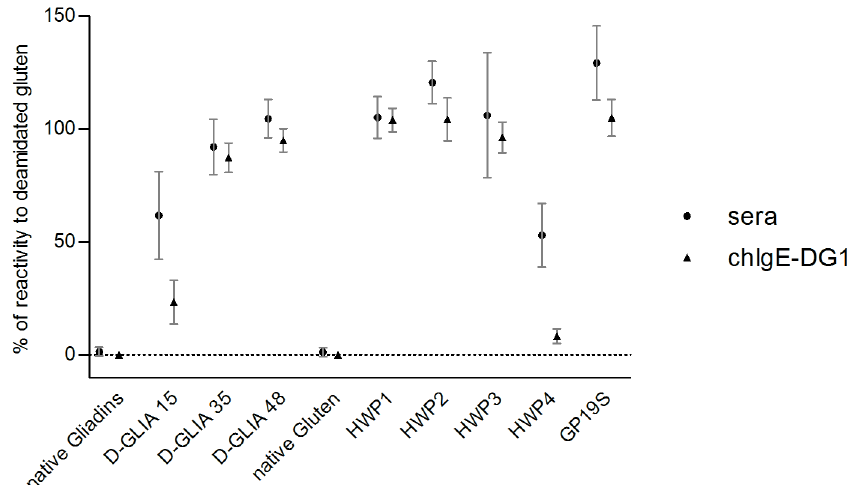
Fig 6. Reactivity of chimeric IgE-DG1 to various deamidated wheat protein fractions and comparison with patients’ reactivity. The concentrations of chIgE-DG1 bound to native gliadins;native gluten; deamidated gliadins(D-GLIA15, 35, 48); D-gluten;HWP1, 2, 3, 4; and GP19S were determined by indirect ELISA. The results were normalizedby determiningthe ratio of IgE for each protein to specific IgE for D- gluten. Symbols represent means of the ratio for humansera (circle, n = 9) or chIgE-DG1 (triangle, n = 3). Error bars represent ± SD. HWP, hydrolyzedwheat protein. GP19S, Glupearl19S ® .